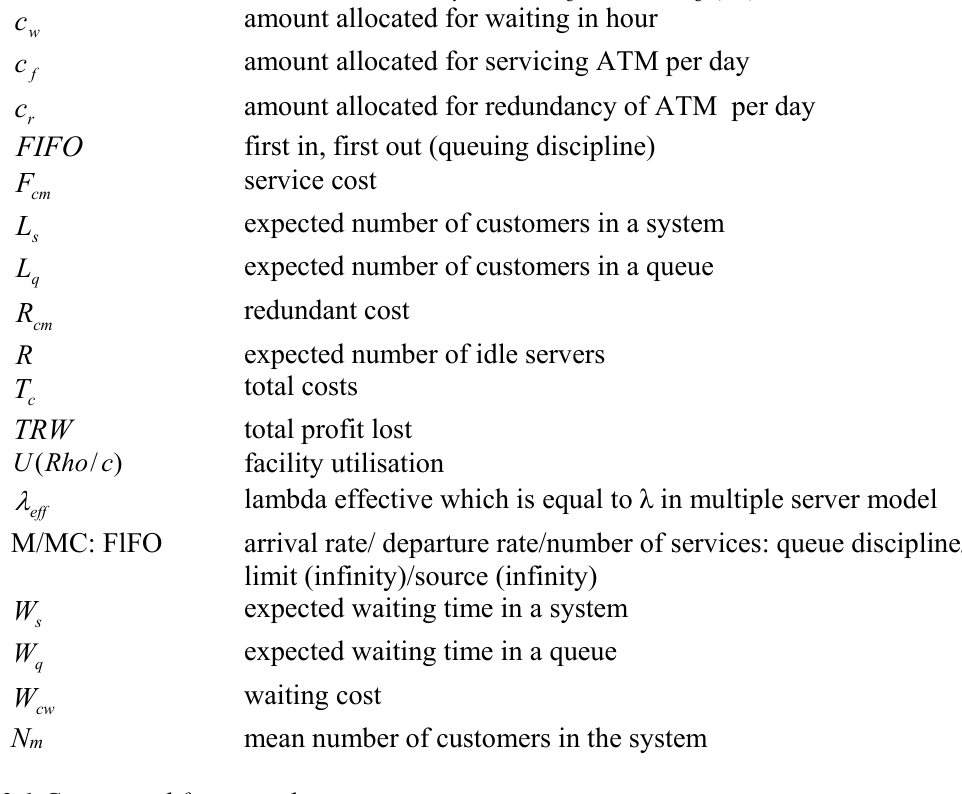
Select criteria for evaluating ATM service Determine the weight of each criterion Determine the values of the criteria using queuing model Construct a normalized decision matrix Construct a weighted normalized decision matrix Determine the ideal and negative ideal solutions Rank the banks